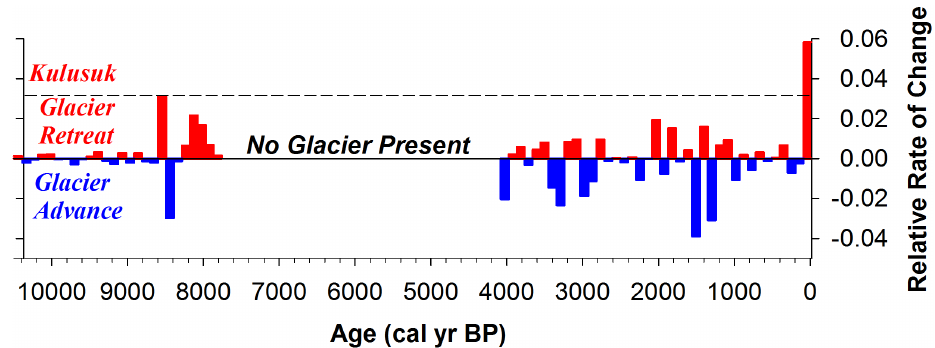
Figure 6. Relative rates of change in the size of the Kulusuk glaciers interpreted from scanning XRF PC1 data. Red bars show 105-year intervals when the average rate was positive indicating glacier retreat, and blue bars show intervals when the average rate was negative indicating glacier advance. Values not calculated during the mid-Holocene when we interpret glaciers to be